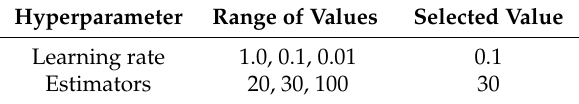
Table 5. RUSBoost hyperparameters selected through grid-search.